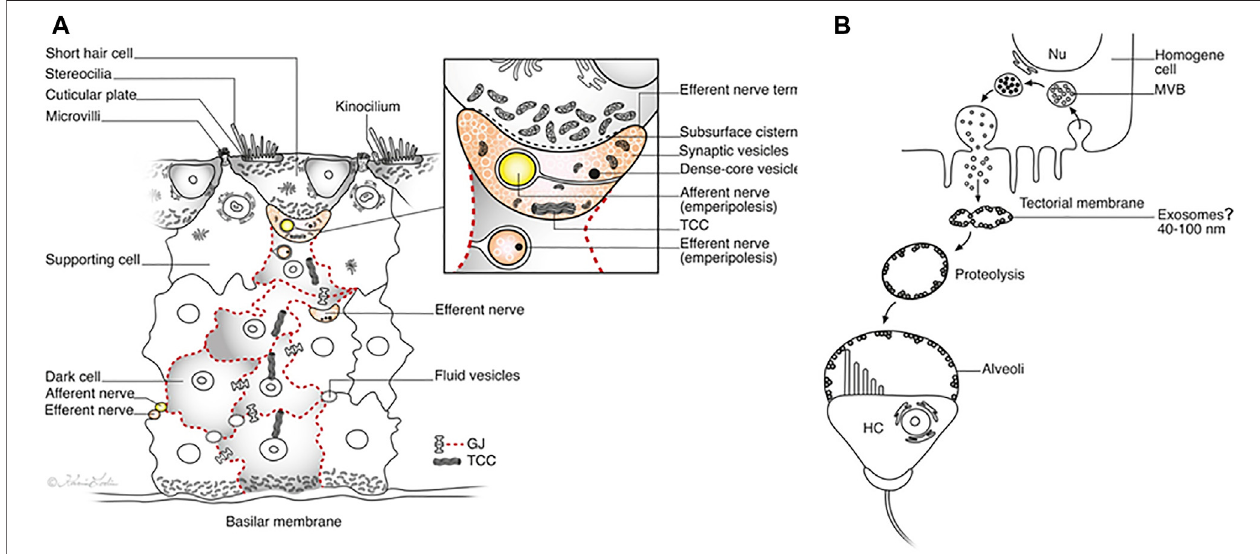
FIGURE 15 | (A) . Illustration showing the proposed steps in the development and re-innervation of HCs in the crocodile papilla basilaris. Activated clusters of electron-dense SCs are margined by GJs (red broken lines). The efferent terminal is encircled by an afferent neuron (emperipolesis), while the SC enfolds an efferent neuron. Intercellular communication and the transfer of genetic information between cells may be gated by GJs and the TCC. The inset shows the synaptic region at higher magni fi cation. (B) . Formation of HC alveoli. Endocytosis of microvesicles and formation of MVBs is followed by secretion of granules and shedding of exosome-like structures. They appear to have a lytic action of the TM matrix, leading to the formation of clear cavities or alveoli around the HC cilia.